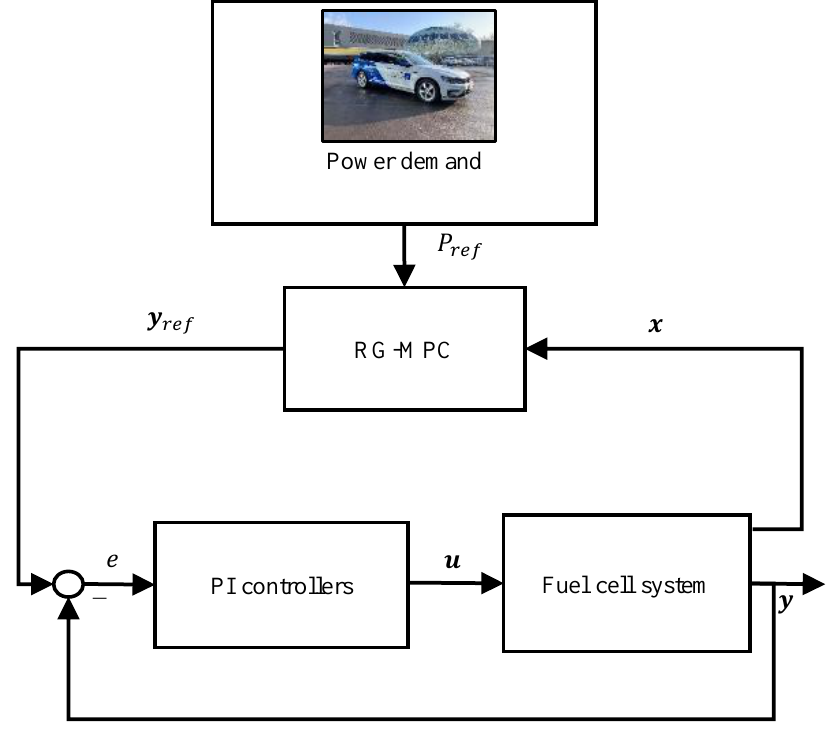
Figure 1. Reference governor model predictive control (MPC) schematics. RG—reference governor;